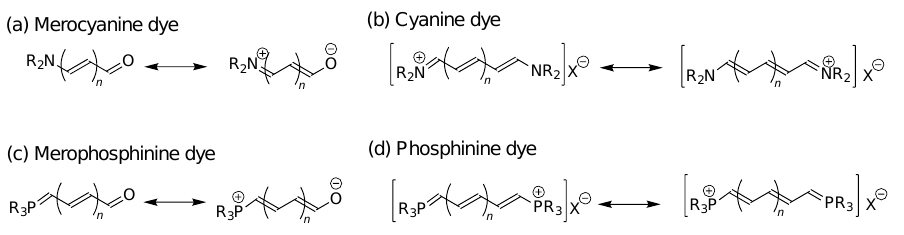
absorption characteristics for pentamethine phosphinine have been reported so far (absorp- tion wavelength: 664–749 nm range in DMSO) [12], little attention has been received to